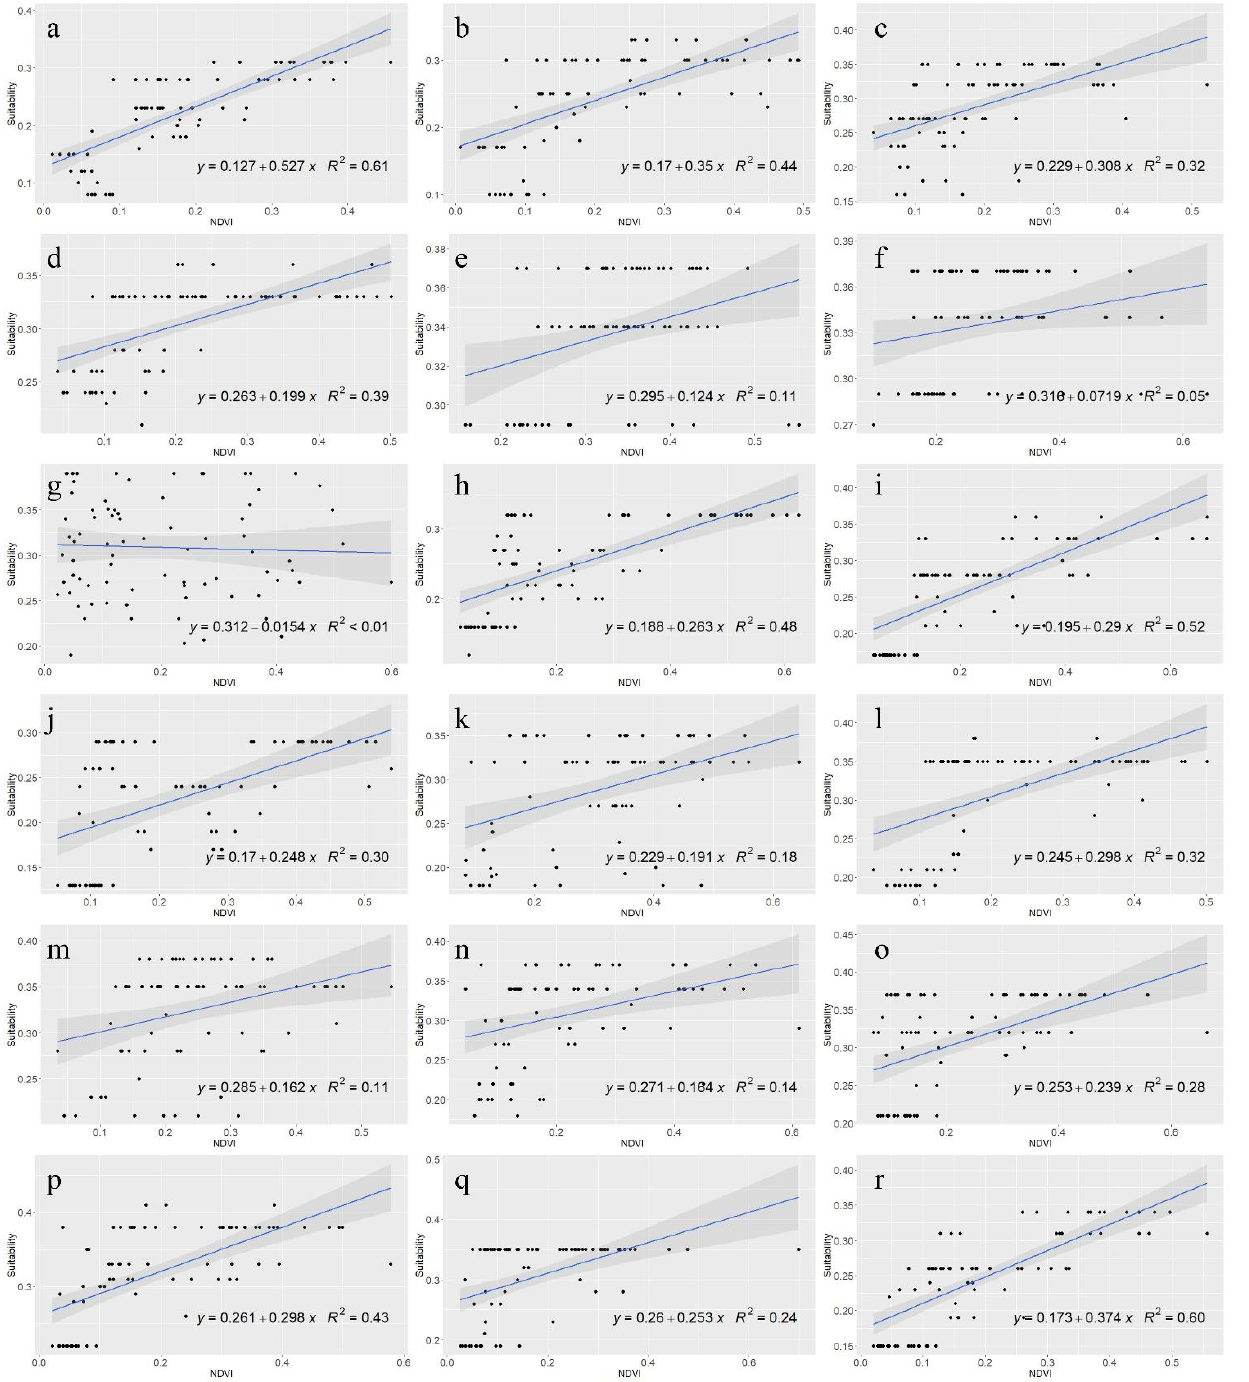
Figure 10. Validations of suitability with NDVI from ( a ) Iwamizawa, ( b ) Shinotsu, ( c ) Kawakami, ( d ) Naganohara, ( e ) Kirishima, ( f ) Taketa, ( g ) Harbin, ( h ) Changchun, ( i ) Shenyang, ( j ) Yanbian, ( k ) Gochang, ( l ) Goesan, ( m ) Haenam, ( n ) Muan, ( o ) kyongwon, ( p ) Orang, ( q ) Pyongyangsong, and ( r ) Taehongdan.